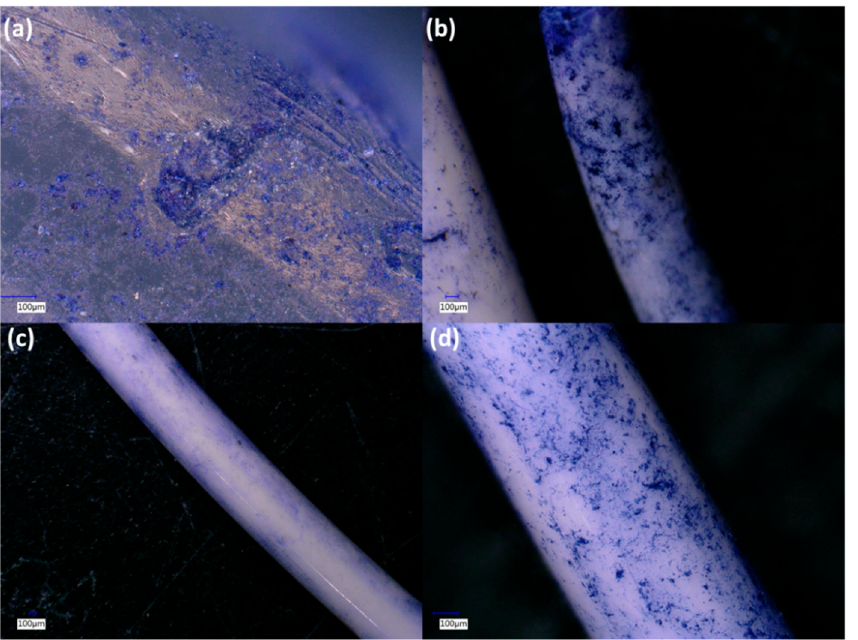
Figure 9. Microscopy images of stained composite filaments that were incubated in soil for a month: ( a ) PLA; ( b ) PLA/TiO 2 90/10 with gelatin; ( c ) PLA/ZnO 90/10; and ( d ) PLA/ZnO 90/10 with gelatin.